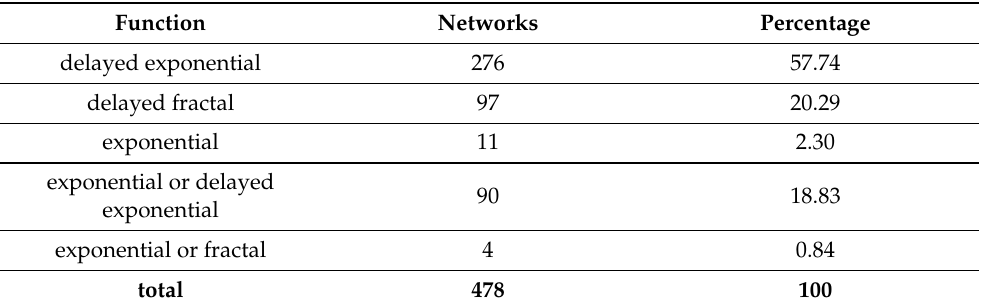
Table 3. The summary of the fit of several models to the minimum number of boxes needed to cover the PPI